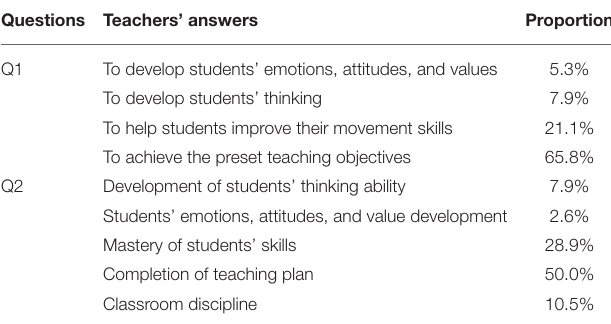
TABLE 2 | Interview data on the main motivation of PE teachers to develop and utilize